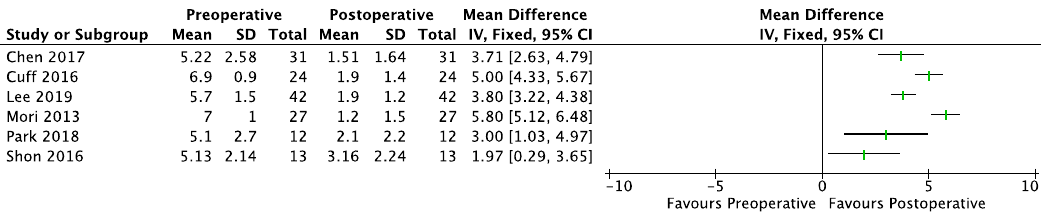
Figure 3. Forest plot of comparison: CMS (Constant ‐ Murley Score), outcome in BT. SD: Standard Deviation.